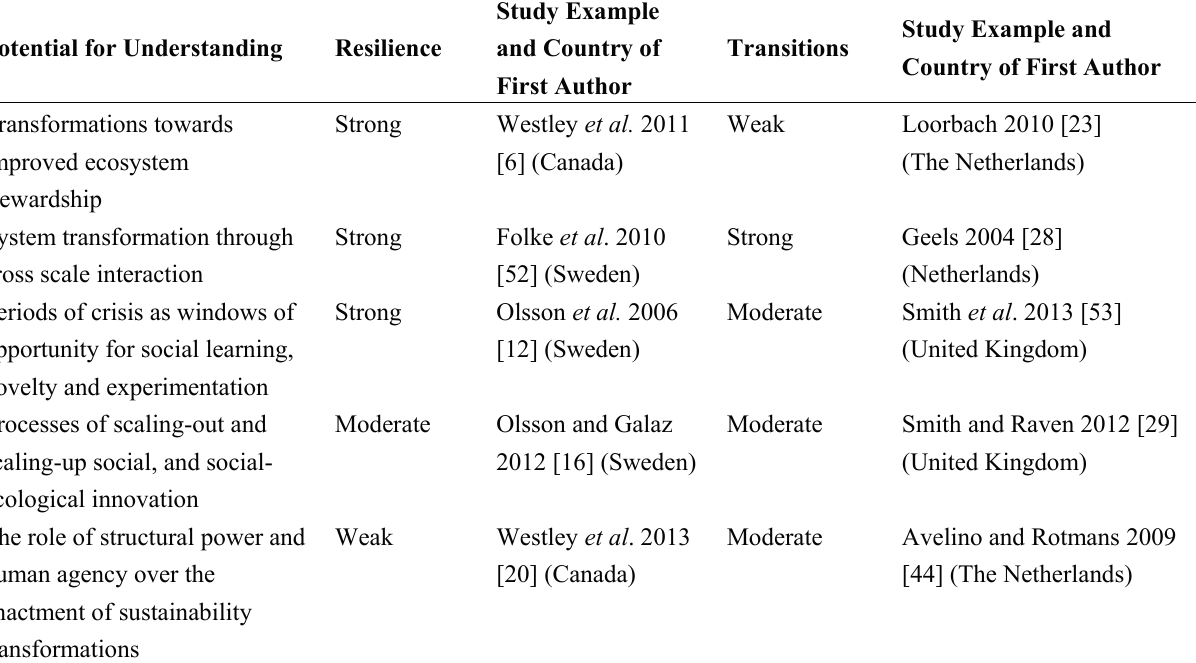
Table 1. Outlines how elements of both resilience and transitions frameworks may be combined to counter their respective